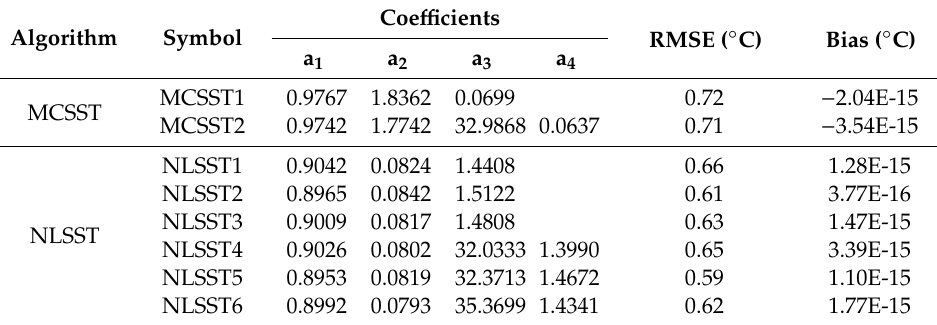
Table 3. Coe ffi cients of MCSST1, MCSST2, NLSST1, NLSST2, NLSST3, NLSST4, NLSST5, and NLSST6 algorithms and root-mean-square error (RMSE) and bias